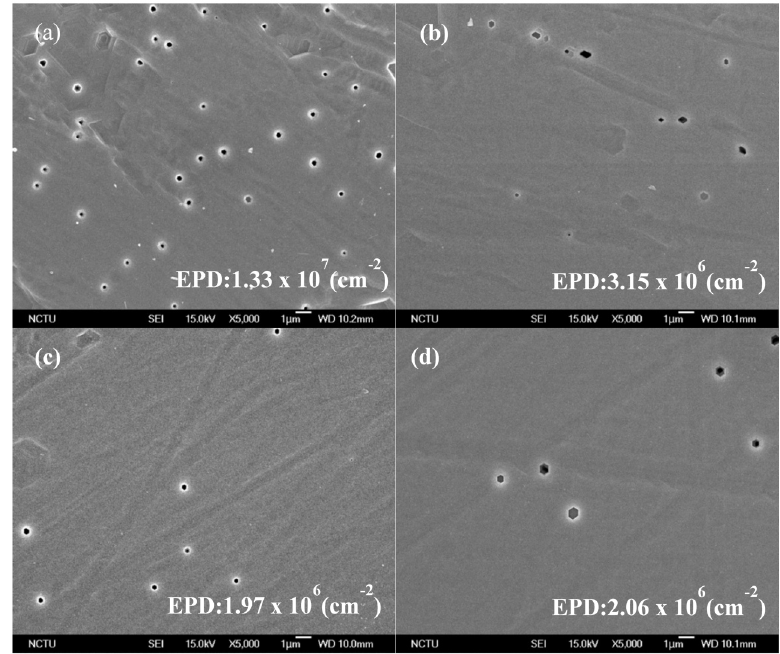
Figure 4. SEM images and Etching Pit density (EPD) of ( a ) S3.00-GaN; ( b ) S0.41-GaN; ( c ) S0.60-GaN and ( d ) S0.87-GaN.